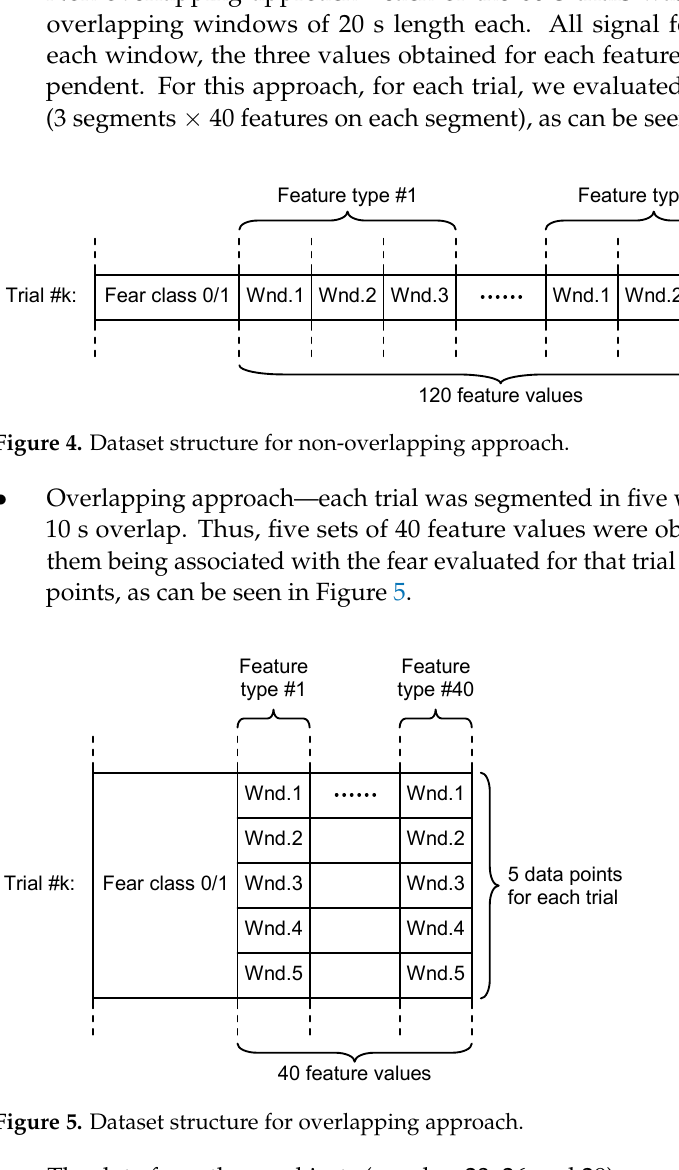
Figure 3. Fear classification process.